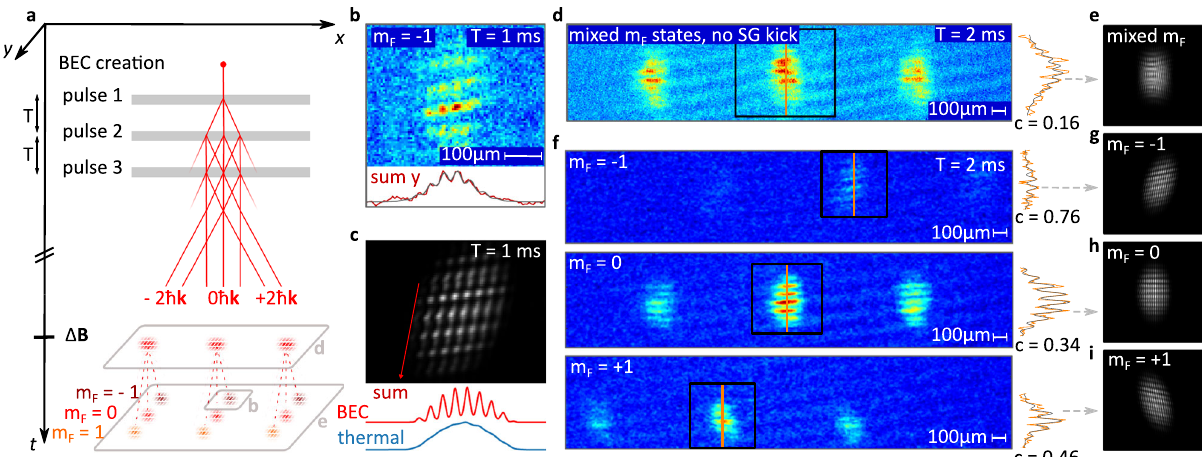
Fig. 3 Experimental and simulated spatial matter-wave fringes. The interference is created in a multi-component BEC by a sequence of three light pulses applied after release. a The associated Bragg processes create several spatially displaced, but still largely overlapping wave packets, resulting in an interference pattern in the three output ports of the interferometer corresponding to a transfer of either + 1, − 1 or 0 effective photon recoils. The fringes are recorded with and without a prior Stern – Gerlach-type spatial separation of the different spinor components. We model the experiment by solving the 2D- Gross-Pitaevskii equation of a BEC interacting with the light fi elds discussed in Fig. 1. b , c A close-up of one output port is shown with the corresponding line integrals along the red line (bottom) as well as their theoretical counterparts. The experiment displays a lower contrast due to spatially varying Rabi frequencies. The temporal sequence of the three light pulses also leads to an effective phase imprinting. d – i The stripe pattern (left) and contrast for a data slice (right) observed with and without the Stern – Gerlach separator are depicted. Without Stern – Gerlach separation the stripe pattern obtained for the slice along the orange line ( d ) features a lower contrast than our model ( e ) which might result from the relative motion of the spinor components. We observe a higher contrast for different magnetic states ( f ). Indeed, the components m F = ±1 feature a tilt of opposite sign with respect to the component m F = 0 which points to a residual magnetic fi eld with a curvature in agreement with our numerical simulations ( g – i